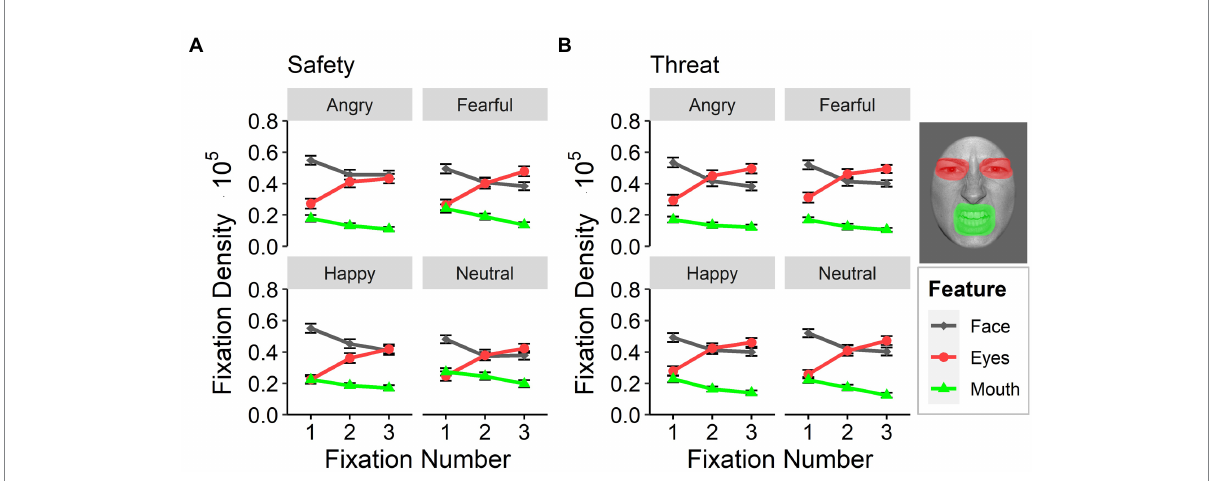
FIGURE 6 Sequential fixations. Fixation densities for the first three sequential fixations after stimulus onset as a function of emotional facial expression (angry, fearful, happy, and neutral) and attended feature (face, eyes, and mouth) for (A) the safety context and (B) the threat context. Error bars indicate standard errors of the mean.